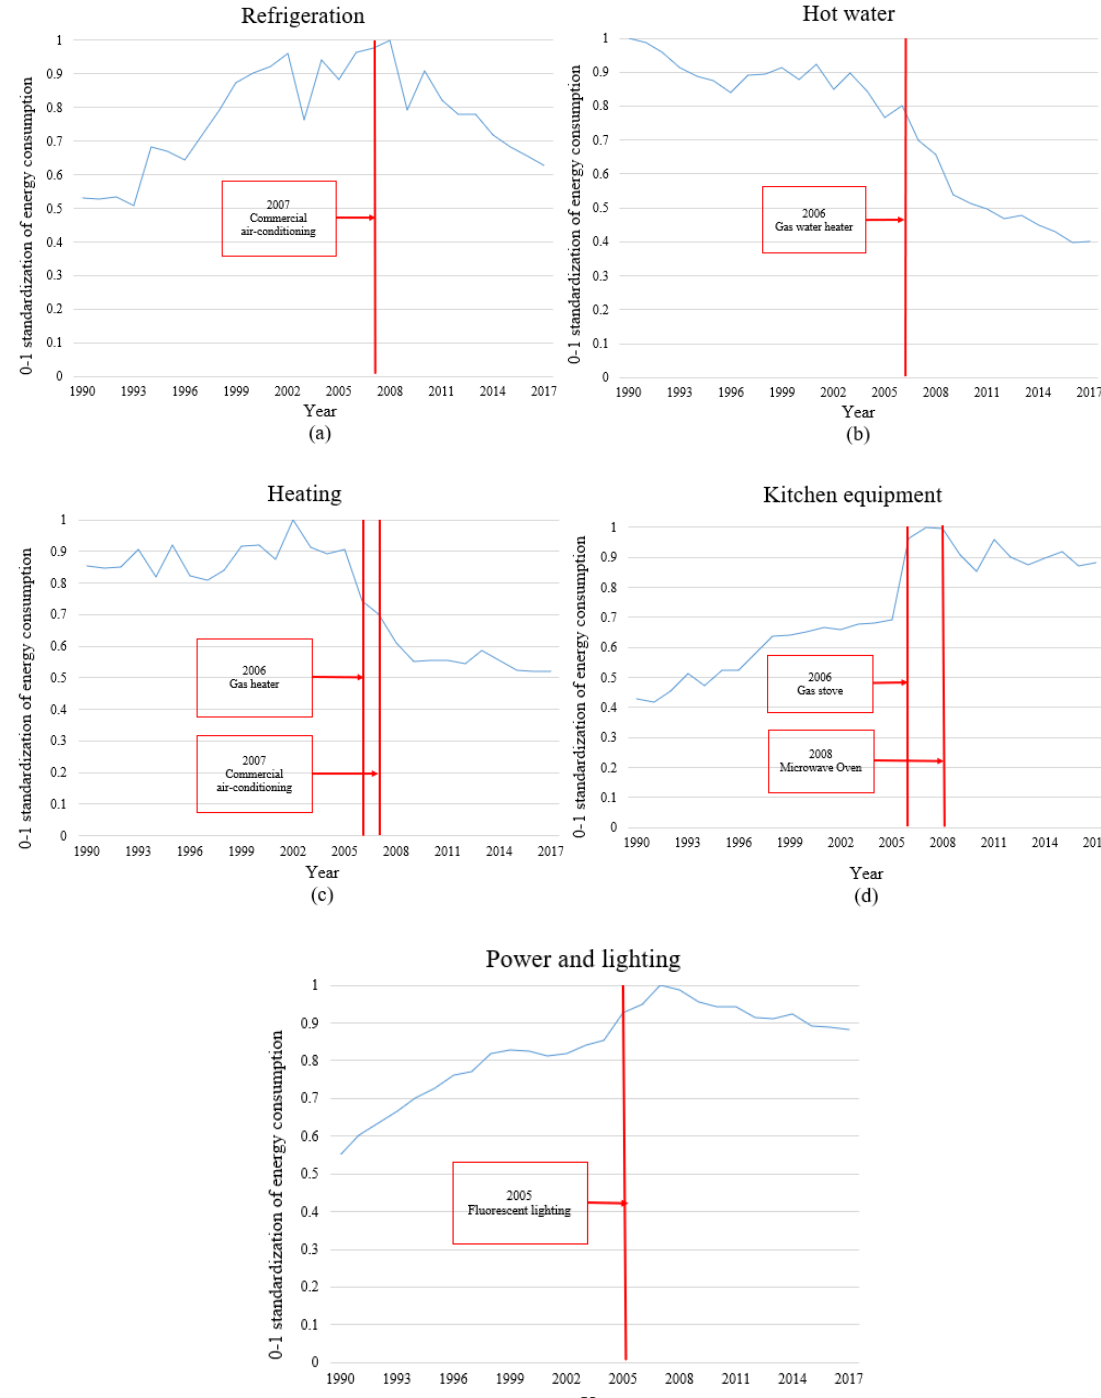
Figure A4. Comparison of different types of energy consumption and the starting time of corresponding policies in residential (( a ) Refrigeration; ( b ) Hot water; ( c ) Heating; ( d ) Kitchen equipment; ( e ) Power and lighting).